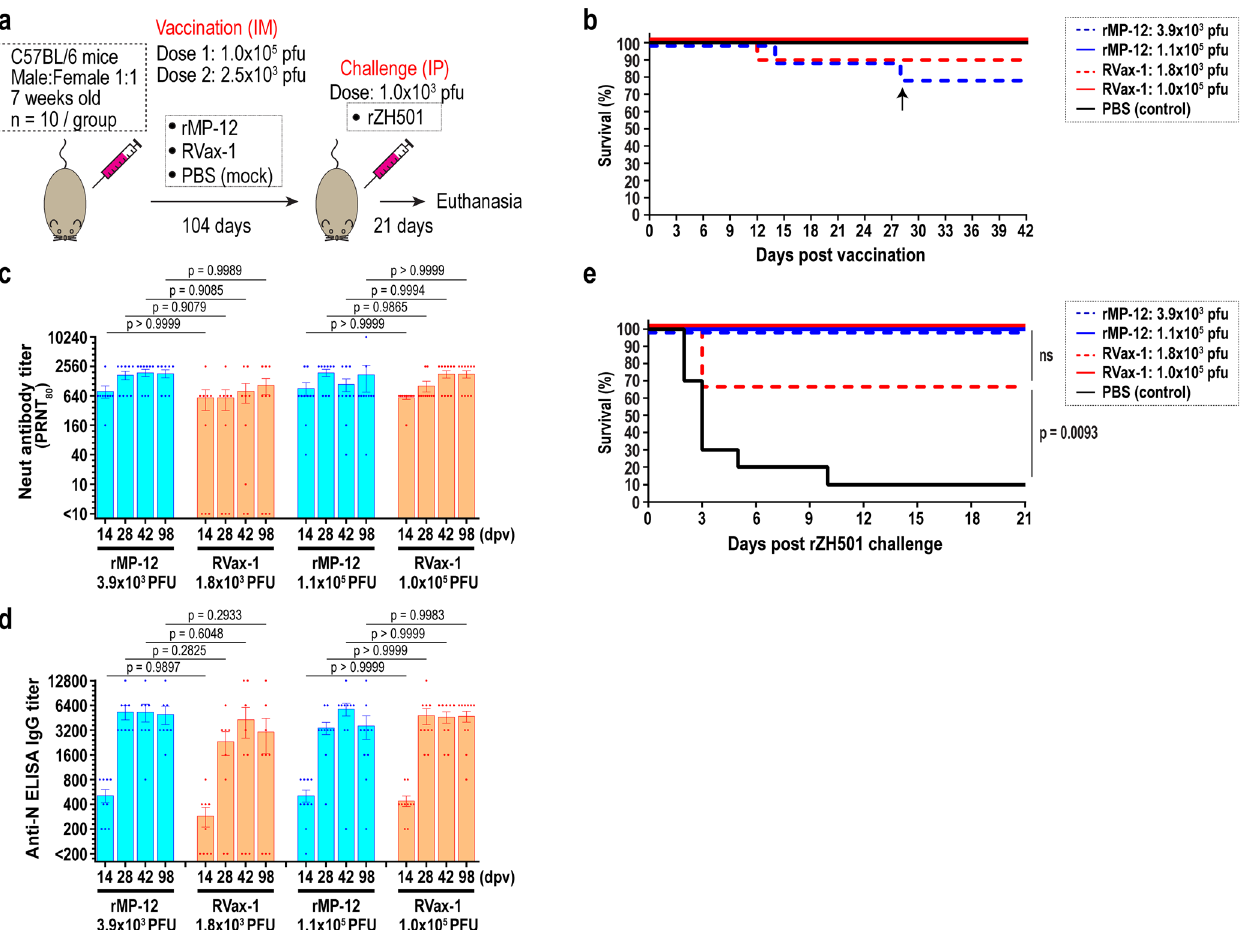
Fig. 5 Immunogenicity and protective ef fi cacy of low doses of rMP-12 or RVax-1 in C57BL/6 mice. a Schematic representation of vaccination and challenge experiment. C57BL/6 mice were IM mock-vaccinated or vaccinated with 2.5 × 10 3 or 1.0 × 10 5 PFU of rMP-12 or RVax-1 ( n = 10 per group), followed by rZH501 challenge at 104 dpv. b The graph represents Kaplan – Meier survival curves after vaccination. Actual vaccine doses were determined by back-titration of inocula. An arrow at 28 dpv indicates an accidental death of animal during anesthesia, c Plaque Reduction Neutralizing Test 80 (PRNT 80 ) neutralizing antibody titers (means ± standard errors) at 14, 28, 42, and 98 dpv are shown in a scattered dot plot graph with the means ± standard errors. Means were compared by one-way ANOVA followed by Tukey ’ s multiple comparison test ( F = 1.663, df = 20). d IgG ELISA titers at 14, 28, 42, and 98 dpv are shown in a scattered dot plot graph with the means ± standard errors. Means were compared by one-way ANOVA followed by Tukey ’ s multiple comparison test ( F = 2.367, df = 15). e